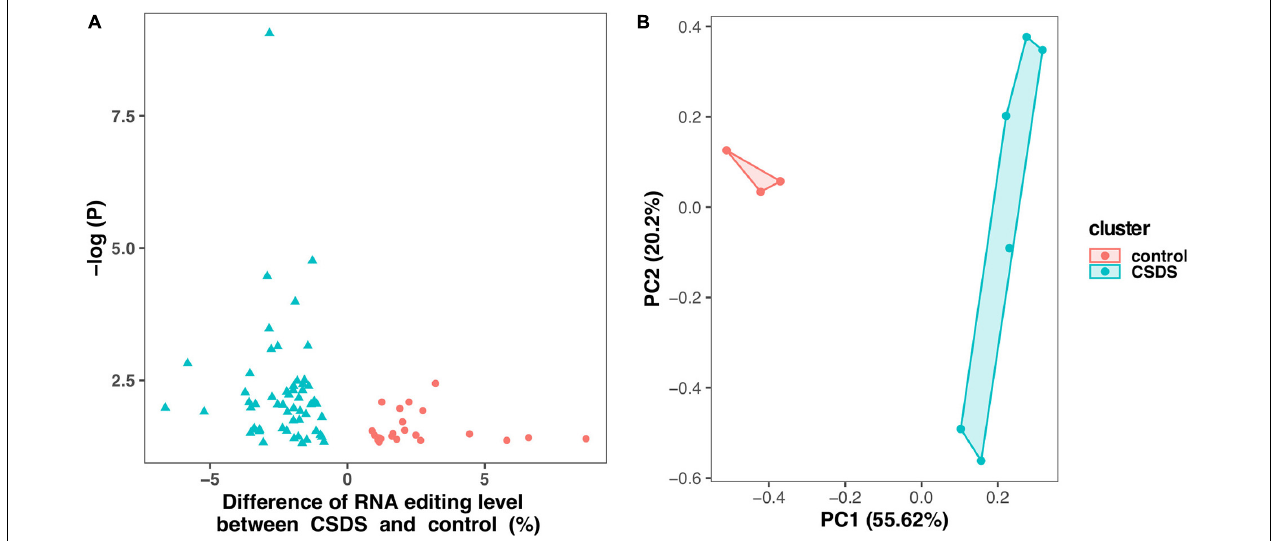
FIGURE 3 | Differential G-to-A RNA editing events between CSDS and controls. (A) A total of 79 events are differentially edited between CSDS and controls, including 56 and 23 are upregulated and downregulated, respectively. (B) Principle component analysis of the 79 events differentially edited between CSDS and